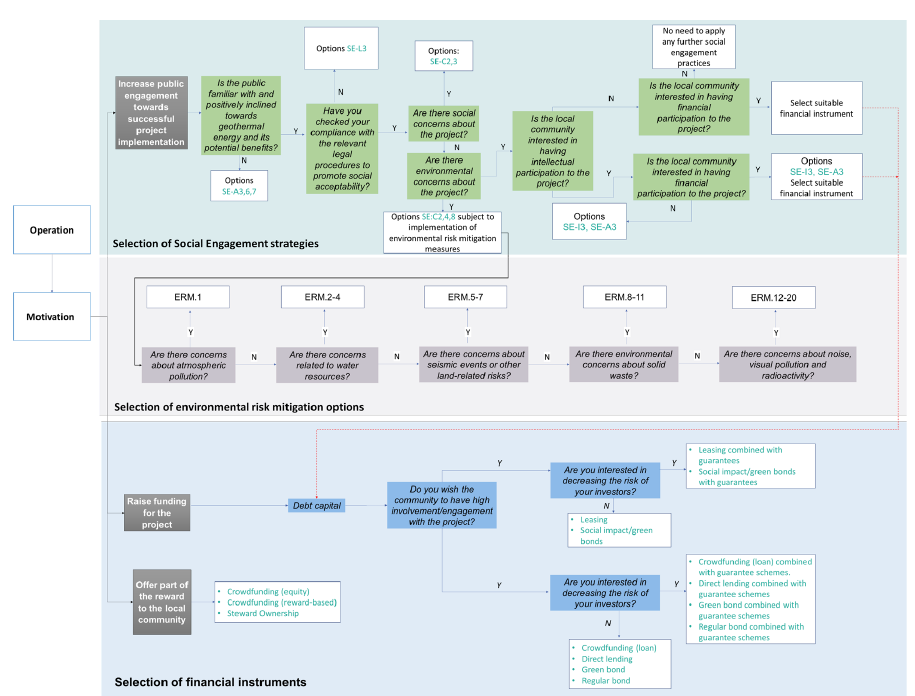
Figure 5. DT—Operation phase.